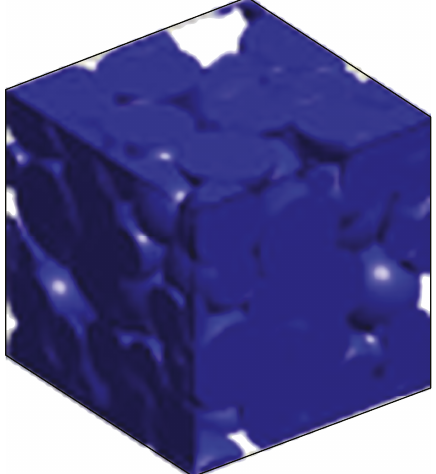
Figure 13: The 3D digital sandstone cores were reconstructed using a process-based reconstruction method. Among them, blue is the skeleton part, and the transparent part is the pore part. Pore space connectivity of 3D digital cores is very good. However, it can also be seen that due to the lack of detailed description of the diagenesis of the rock, the three-dimensional digital core obtained by the process method has a very single pore space and is di ffi cult to reconstruct the complicated pore